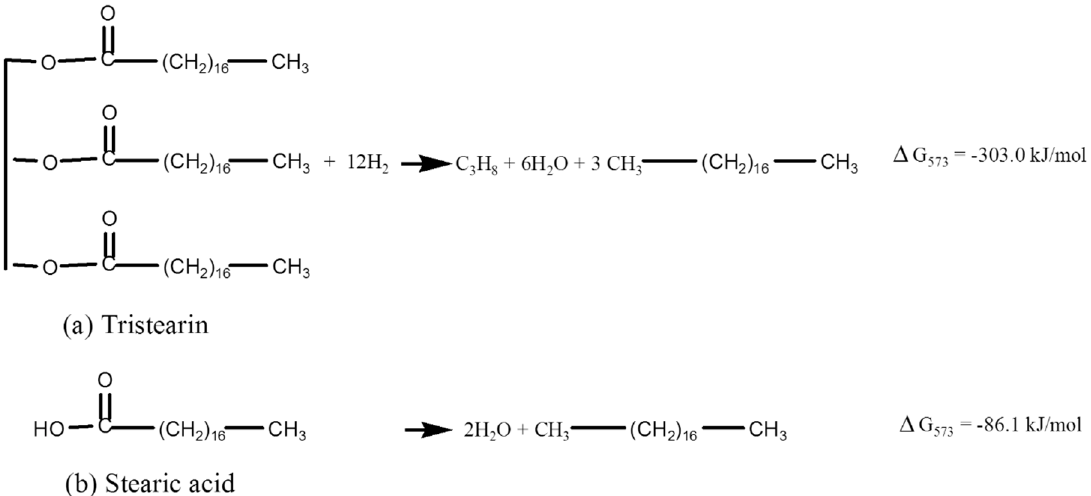
Figure 2. Reaction pathways of hydrodeoxygenation (HDO) in ( a ) tristearin and ( b ) stearic acid [35].